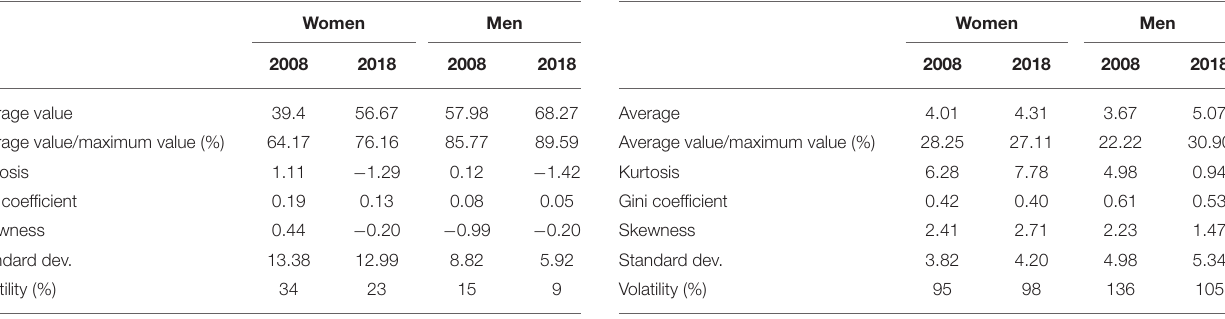
TABLE 2 | KILM 1—descriptive statistics for the years 2008 and 2018.